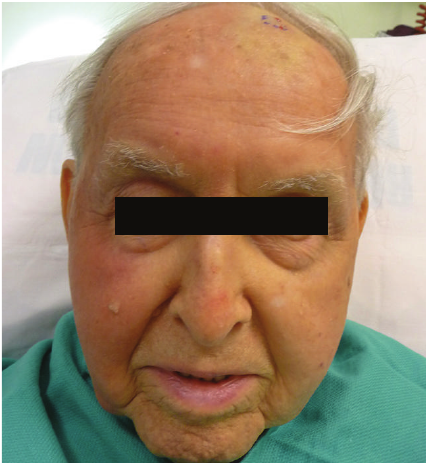
Figure 1: Clinical presentation of the patient with angiosarcoma prior to